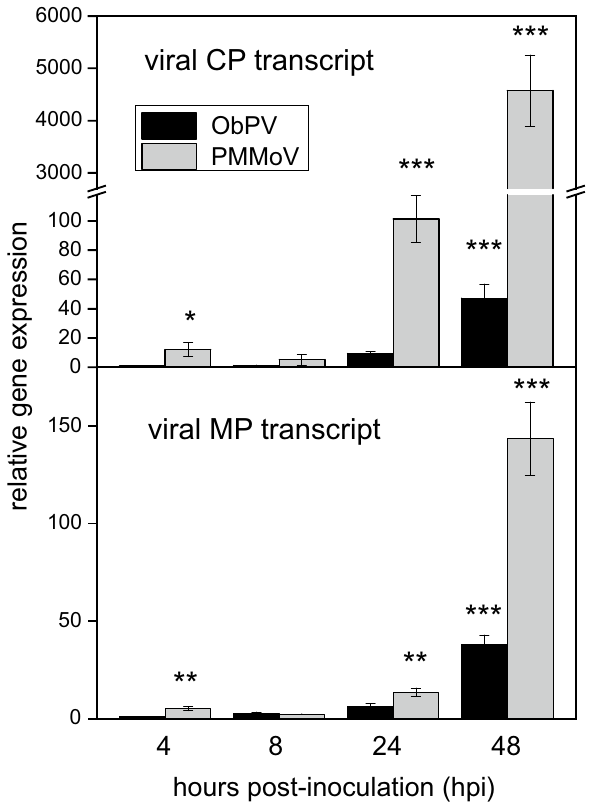
Figure 1. Multiplication of Obuda pepper virus (ObPV) and Pepper mild mottle virus (PMMoV) in the inoculated pepper leaves at different time points following the inoculations. The amount of mRNAs encoding viral movement proteins (MP) and coat proteins (CP) of ObPV and PMMoV was detected by real-time RT-qPCR (for primers see Supplementary Table S7). Reverse transcriptions (RT) of viral RNAs were carried out by using the reverse primers of the MP or CP specific primer pairs instead of an Oligo(dT) primer. Mean values of three independent experiments are shown ± SD. Relative expression values were calculated by dividing each expression value with the expression of ObPV genes at 4 hpi. The symbols *, ** and *** show significant differences between ObPV- and PMMoV-inoculated plants at P < 5%, < 1% and < 0.1%,